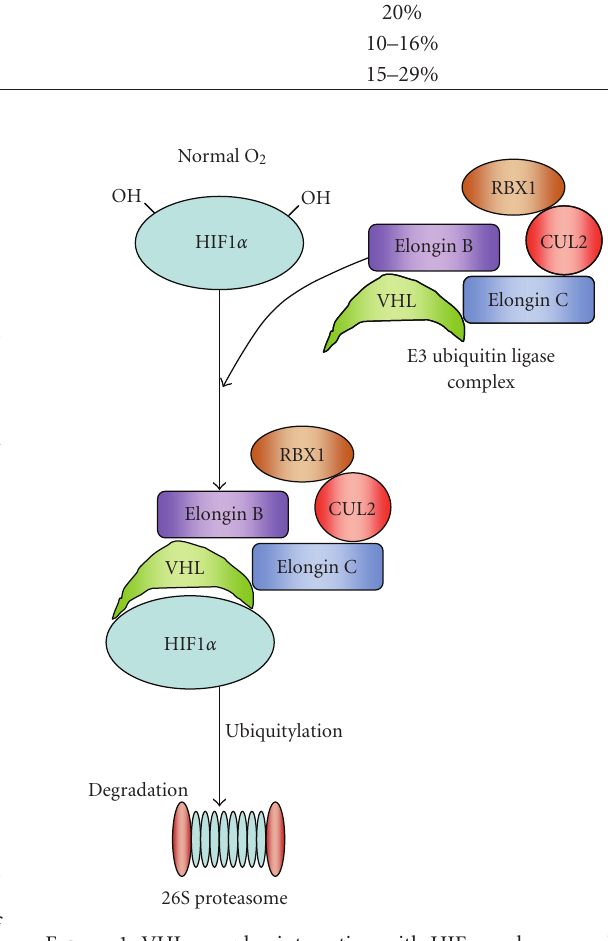
Figure 1: VHL complex interaction with HIF α under normal O 2 levels. Its normal function leads to HIF α degradation (see text for